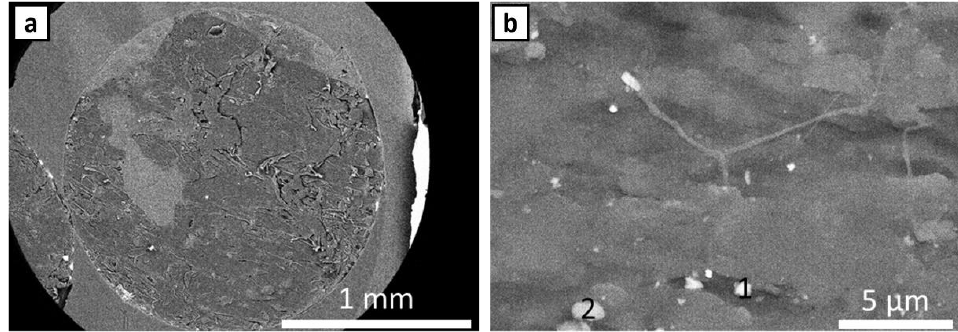
Figure 3. EDS spectra of ABS w/5%CF identifying chopped fibers and oxygen in ABS matrix. Num- bers 1 – 4 correspond to the respective areas in Figure 2b.